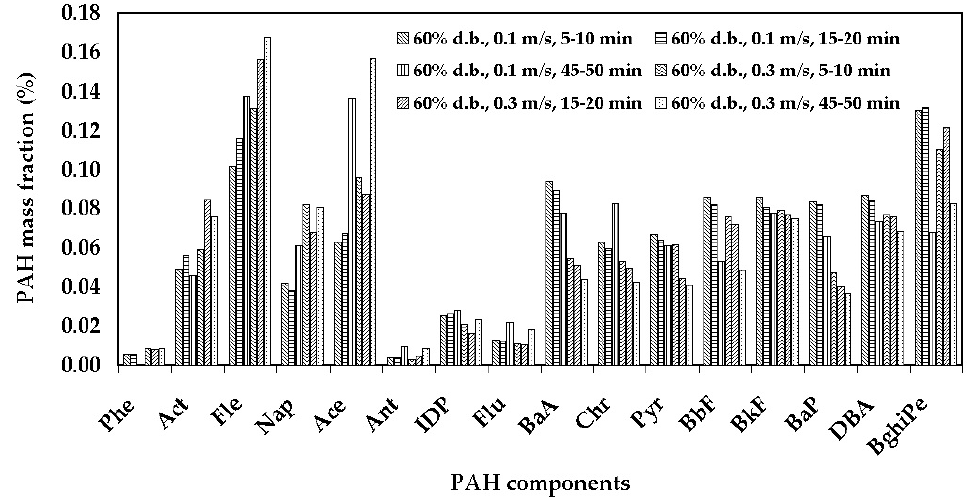
Figure 8. Mass faction of each PAH component in smoke particle samples from the palm oil sewage sludge bio-char combustion for different clean air speeds and combustion periods (Phe = Phenanthrene, Act = Acenaphthylene, Fle = Fluorene, Nap = Naphthalene, Ace = Acenaphthene, Ant = Anthracene, IDP = Indeno[1,2,3-cd]pyrene, Flu = Fluoranthene, BaA = Benz[a]anthracene, Chr = Chrysene, Pyr = Pyrene, BbF = Benzo[b]fluoranthene, BkF = Benzo[k]fluoranthene, BaP = Benzo[a]pyrene, DBA = Dibenz[a,h]anthracene, and BghiPe = Benzo[g,h,i]perylene).